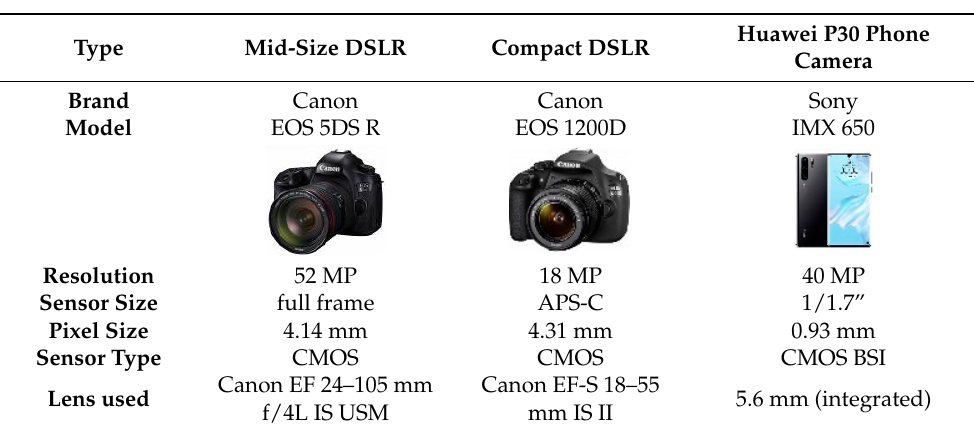
Table 1. Specifications of the employed imaging sensors.